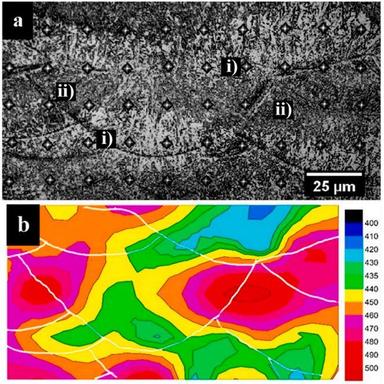
(a) "Fish scale"-like microstructure in as-built sample (in the building direction) with the indentation grid depicted; (b) a Vickers hardness mapping along the region shown in a).